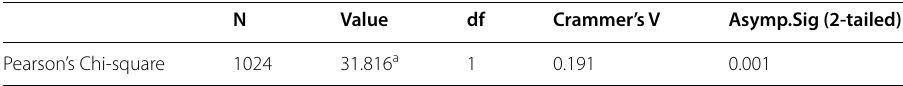
Table 2 Chi-square tests (gender)